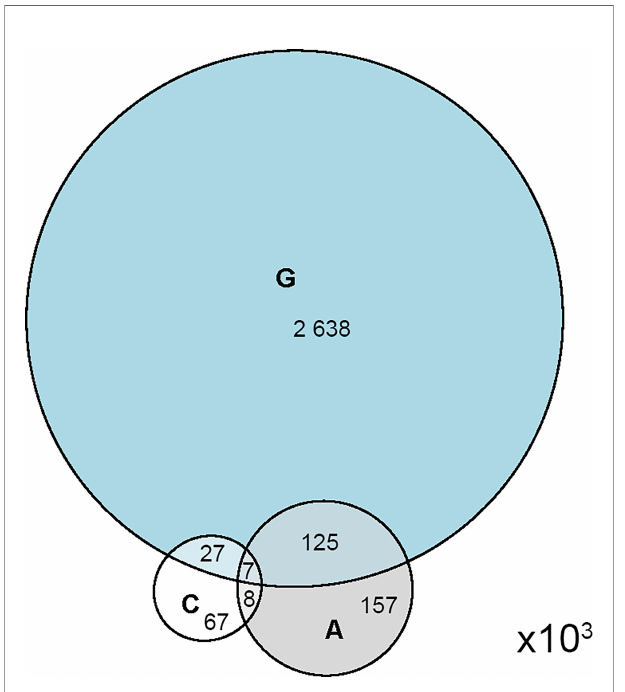
FIGURE 1 | Venn diagram representing the relative size and overlap between the three deep panning selected mimotope